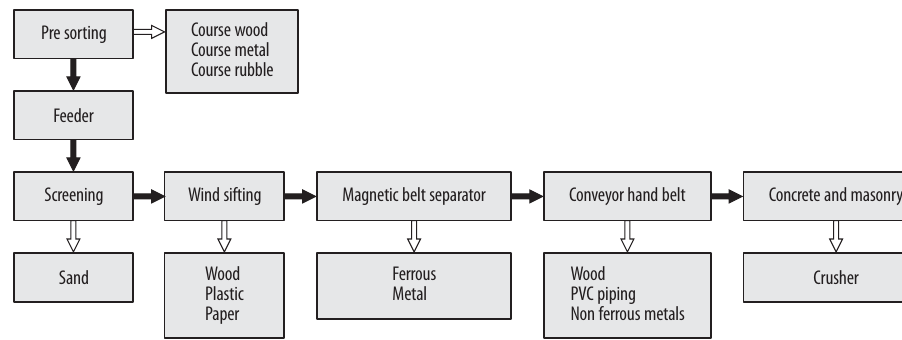
Figure 5. Proposed earthquake waste management plan,